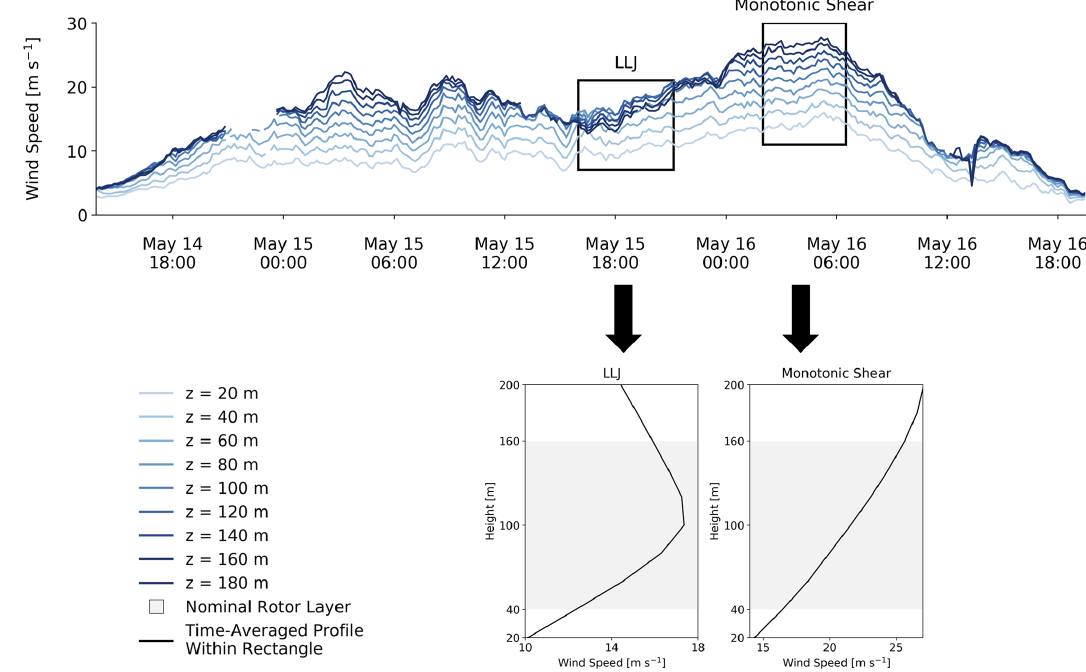
Figure 2. Example of high-shear event as measured by lidar on the NE buoy. Location of the NE buoy is provided in Table 1. Time series between 13:50UTC on 14 May 2020 and 19:30UTC on 16 May 2020 (top). The data within the two black boxes are time-averaged and shown below the time series as examples of low-level jet (LLJ) and monotonic-shear periods. Table 1. Summary of data set being analyzed: site name, location (latitude, longitude), period analyzed, distance from coast due west, lidar measurement heights (above mean sea level) and quantities being